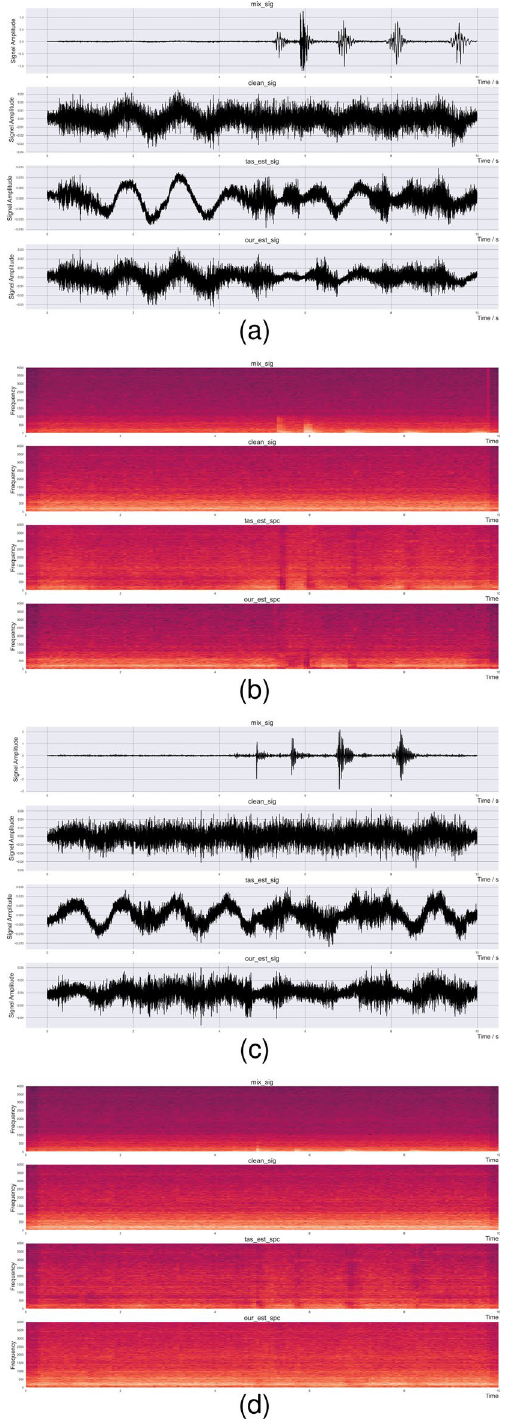
Fig. 5 The output of two